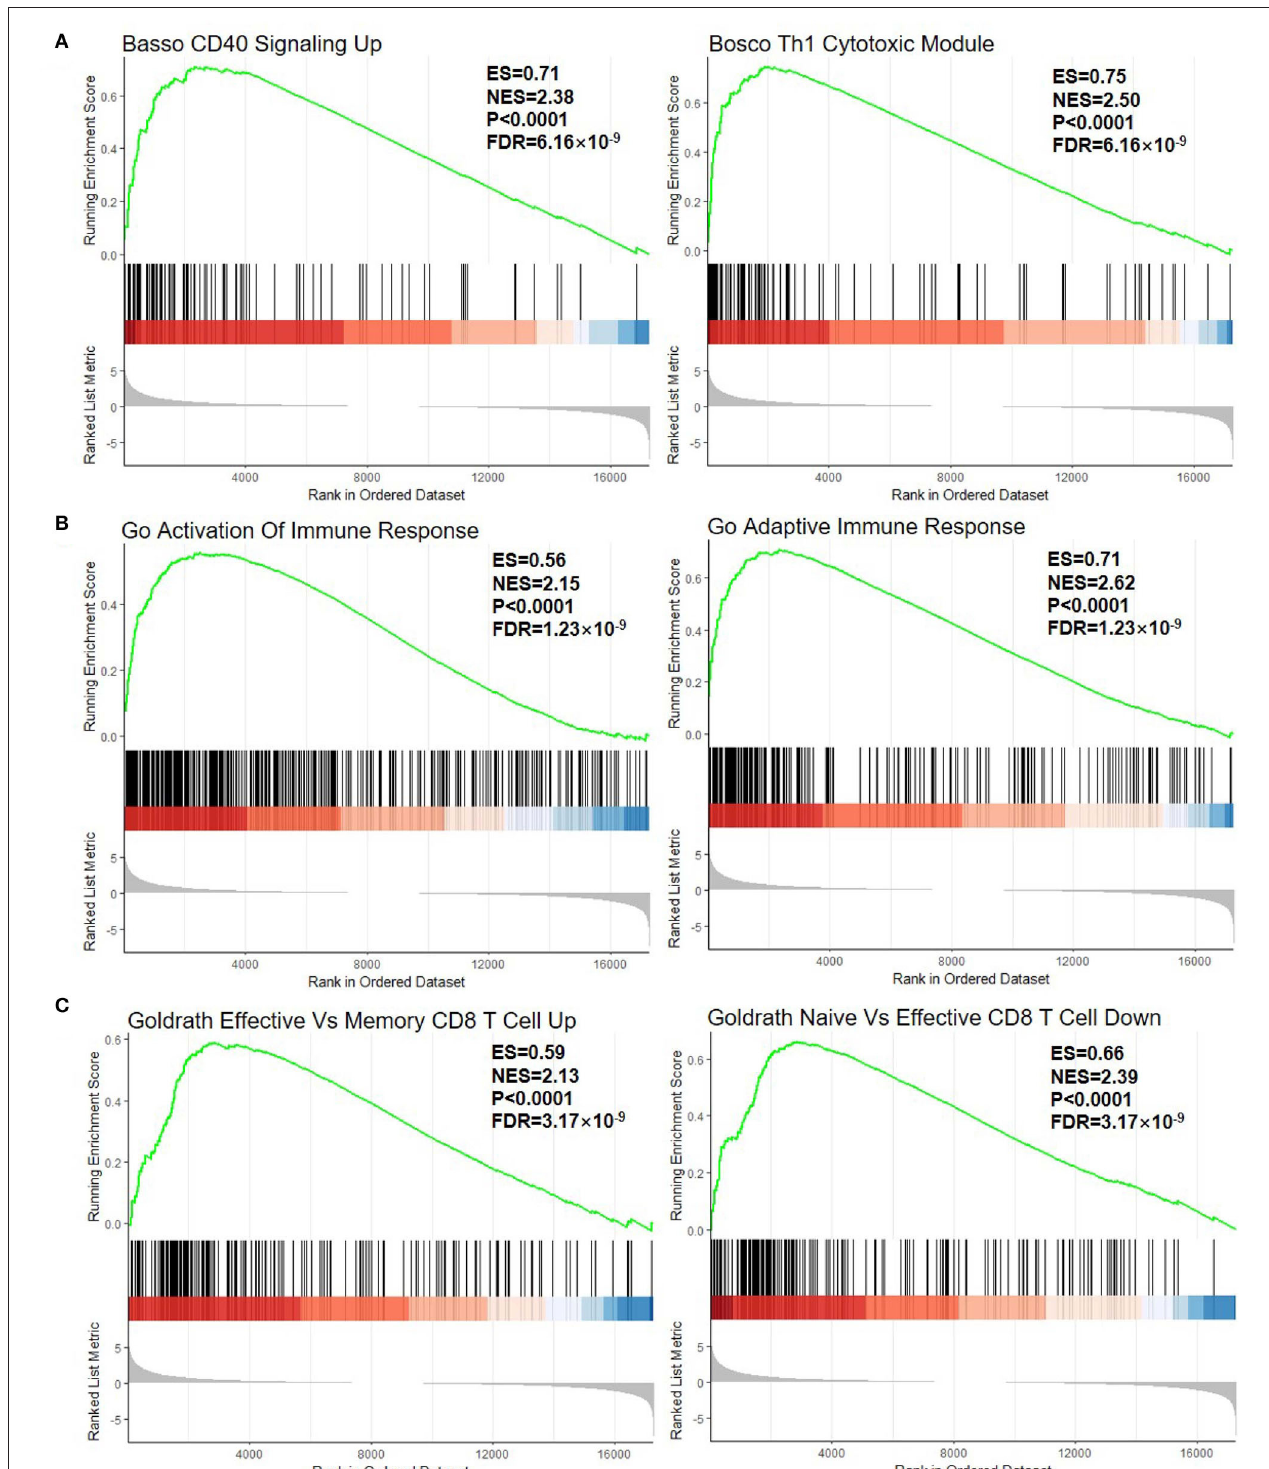
FIGURE 2 | GSEA plot of all the detected genes. (A) C2, curated gene sets; (B) C5, the Ontology Gene sets; and (C) C7, immunologic signature gene sets. GSEA, gene set enrichment analysis; ES, enrichment score; NES, normalized enrichment score. The green line means enrichment profile. The red part of the heat map represents the genes that are highly expressed in rheumatoid arthritis (RA), the blue part of the heat map represents the genes that are highly expressed in osteoarthritis (OA), and the gray area of the heat map represents the signal-to-noise ratio of each gene.